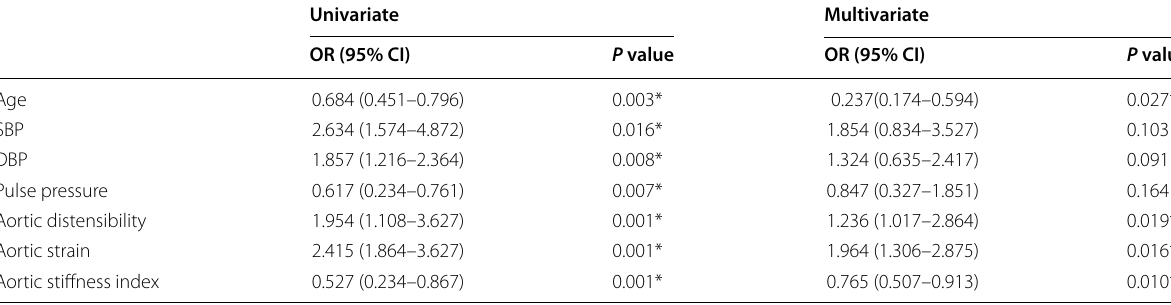
SBP, systolic blood pressure; DBP, diastolic blood pressure